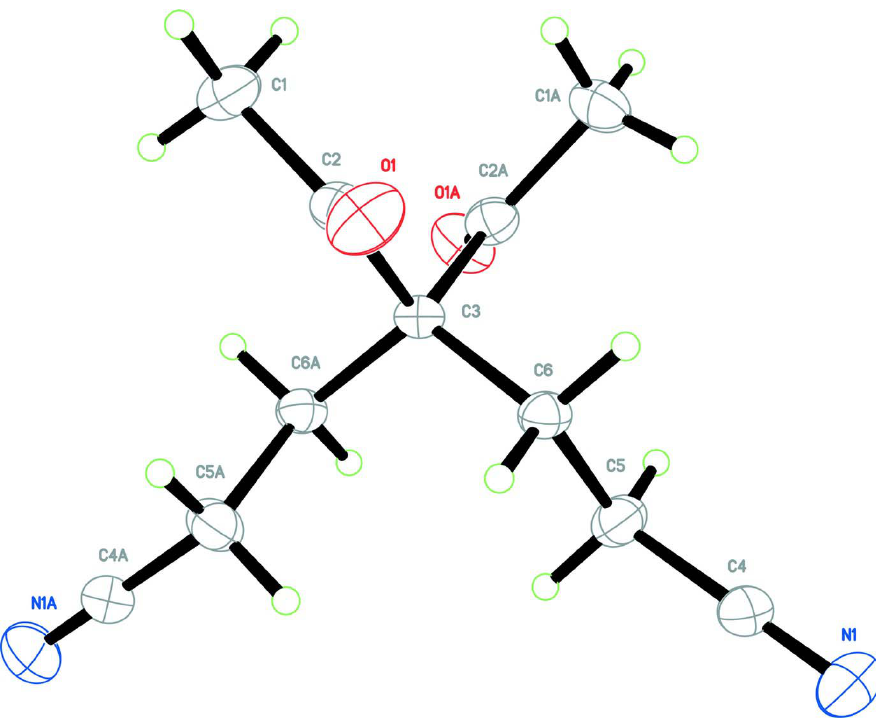
Figure 1 A view of the molecular structure of (I) showing the atom-numbering scheme and 30% displacement ellipsoids (arbitrary spheres for the H atoms).